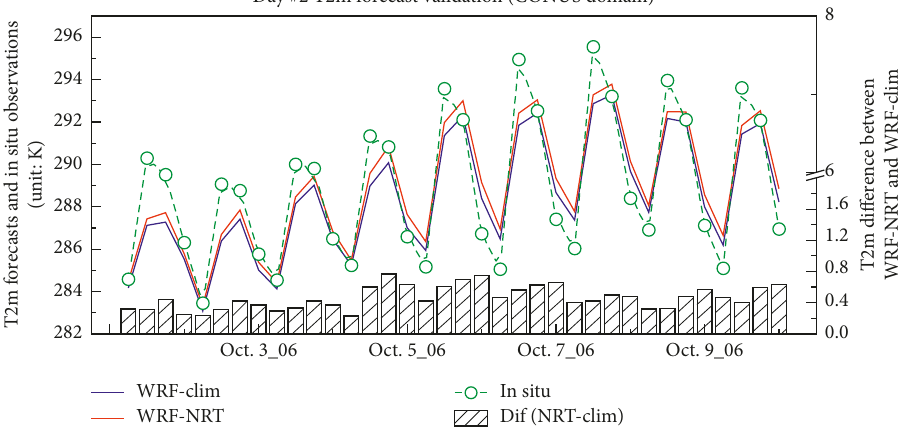
Figure 5: Comparison of 2m surface air temperature forecasts between WRF runs (with climatology and NRT GVF) and in situ ob- servations; T2m averaged from all validation sites over